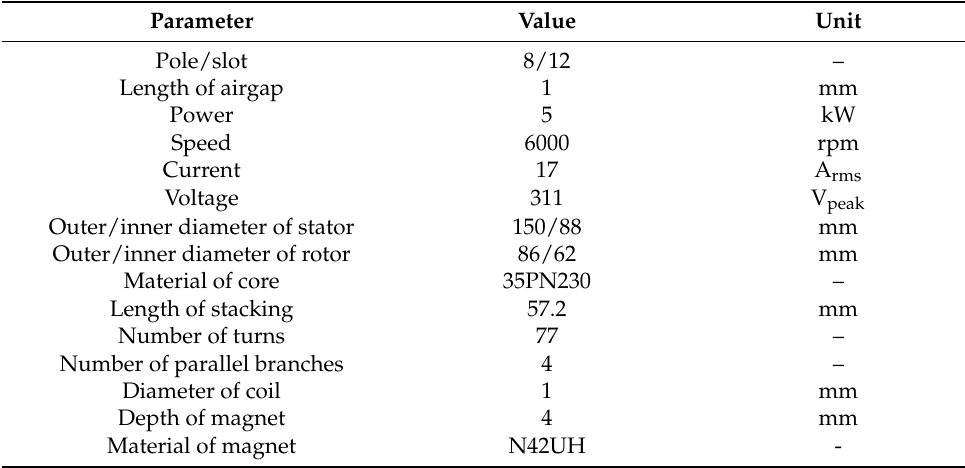
Table 2. Specifications for the magnetic bearing in an integrated magnetic bearing motor.